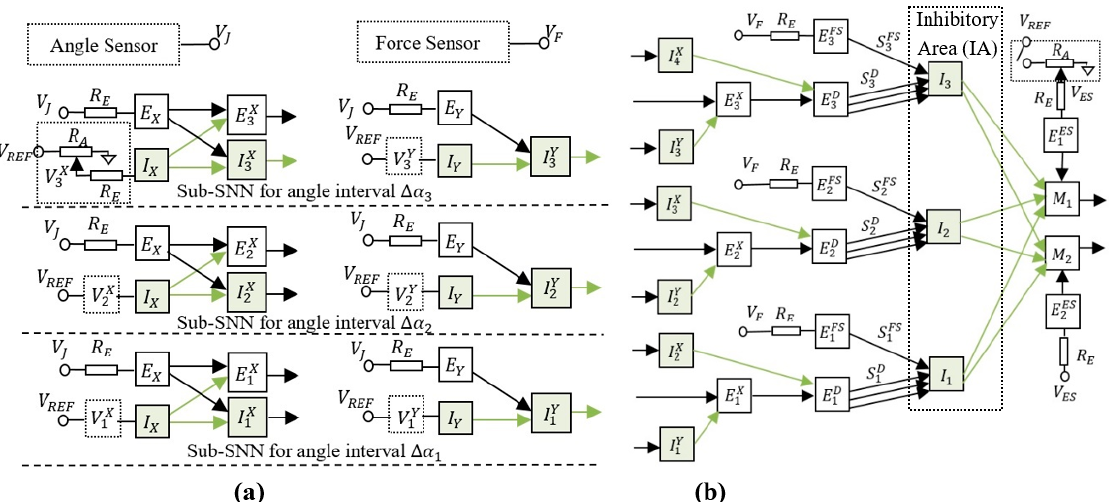
Figure 2. The adaptive neural structure which can be trained using associative learning mechanisms to stop the finger in three subintervals of the rotation range; ( a ) the encoding layers include input neurons E X , E Y (excitatory) and I X , I Y (inhibitory) that activate a subset of outputs for each rotation interval ∆ α 1 − 3 ; ( b ) the decoding layers used to activate one of the excitatory neurons E D and adjust the weights of the synapses S D accordingly; the switch determines the activation of the input neurons E ES and, consequently, of the motor neurons M 1,2